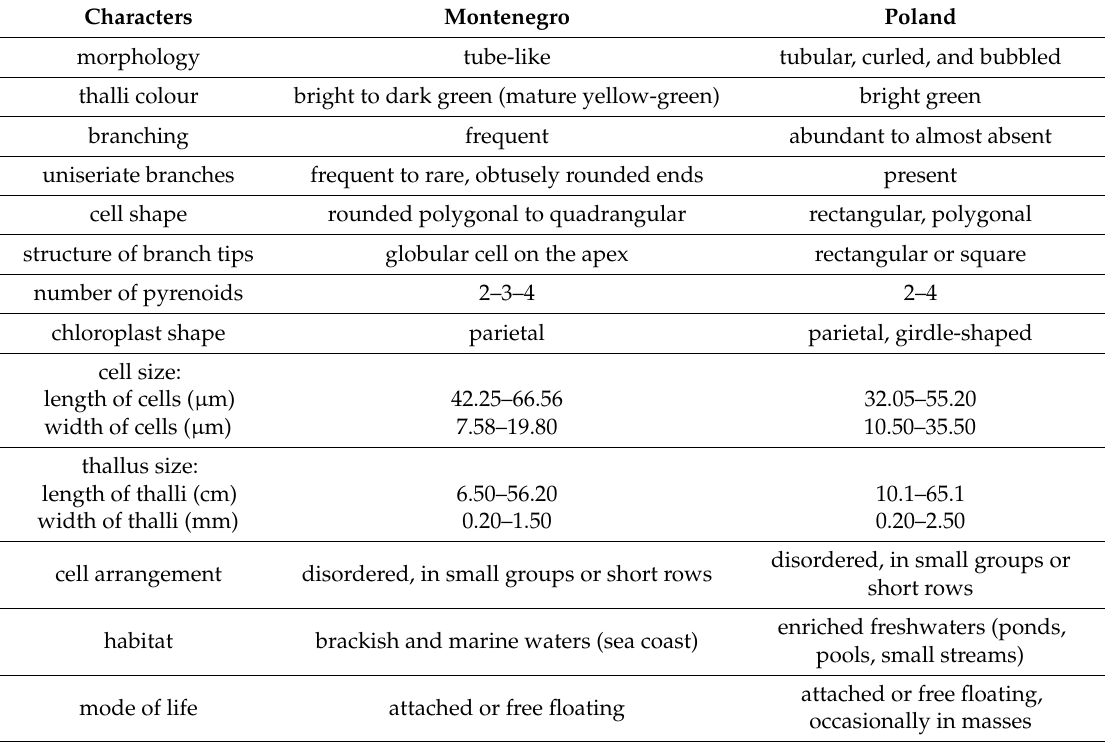
Table 1. Morphological characteristics of Ulva pilifera from Montenegro and Poland